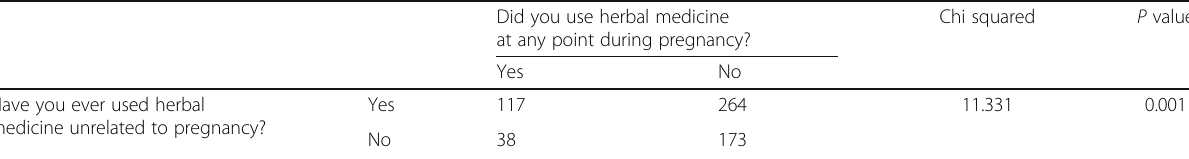
Table 4 Association between herbal medication use during pregnancy and ever use